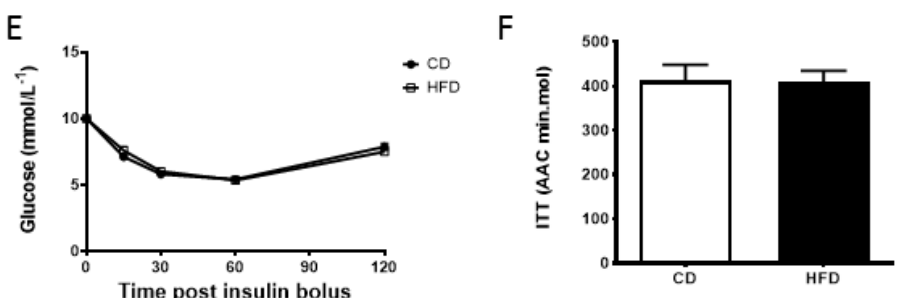
Figure 1. The e ff ect of diet on body weight and glucose and insulin tolerance during initial diet phase. ( A ) Weekly weigh gain of males from 4 weeks until 14 weeks; ( B ) amount of total weight gained during the initial diet phase; ( C ) glucose tolerance as assessed by glucose tolerance test (GTT, 2g / kg) during initial diet phase; ( D ) glucose area under the curve (AUC, min.mmol) during GTT during initial diet phase; ( E ) insulin tolerance as assessed by insulin tolerance test (ITT, 1.0 IU) during initial diet phase; and ( F ) glucose area above the curve (AAC, min.mol) during ITT during initial diet phase. Data is expressed as mean ± standard error of the mean (SEM). n = 24 males per diet group. CD; control diet, HFD; high fat diet. Data was analyzed by a repeated measures analysis of variance (ANOVA) for weight gain or a one way ANOVA for GTT and ITT. Di ff erent letters denote significantly distinct groups at p < 0.05.